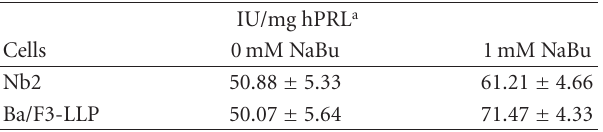
Table 3: Bioactivity of purified hPRL obtained from CHO cells treated or not with NaBu, determined via Nb2 or Ba/F3-LLP cells against the First International Standard for recombinant hPRL (WHO 97/714) with an activity of 57.2 ± 11.4 IU/mg. IU/mg hPRL a Cells 0mM NaBu 1mM NaBu Nb2 50.88 ± 5.33 50.07 ± 5.64 71.47 ±